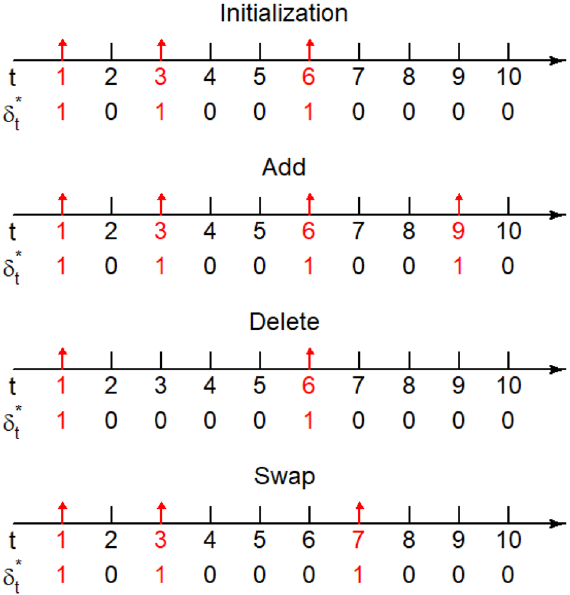
Figure 2. Illustration of the add – delete – swap algorithm. Based on the initialization δδδ ∗ = δδδ ( g ) = ( 1, 0, 1, 0, 0, 1, 0, 0, 0, 0 ) , the candidate δδδ ∗ in the ( g + 1 ) -th update can be obtained as: (i) (1, 0, 1, 0, 0, 1, 0, 0, 1, 0) by selecting the add operation and updating δ ∗ 9 as 1; (ii) (1, 0, 0, 0, 0, 1, 0, 0, 0, 0) by selecting the delete operation and updating δ ∗ 3 as 0; (iii) (1, 0, 1, 0, 0, 0, 1, 0, 0, 0) by selecting the swap operation and exchanging values of δ ∗ 6 and δ ∗ 7